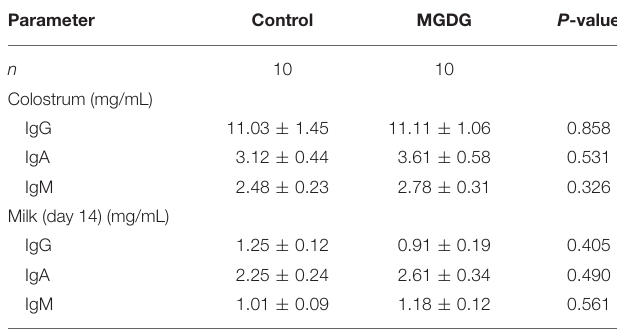
TABLE 4 | Effects of dietary MGDG supplementation during late gestation and lactation on sow back fat thickness and estrus interval. Parameter